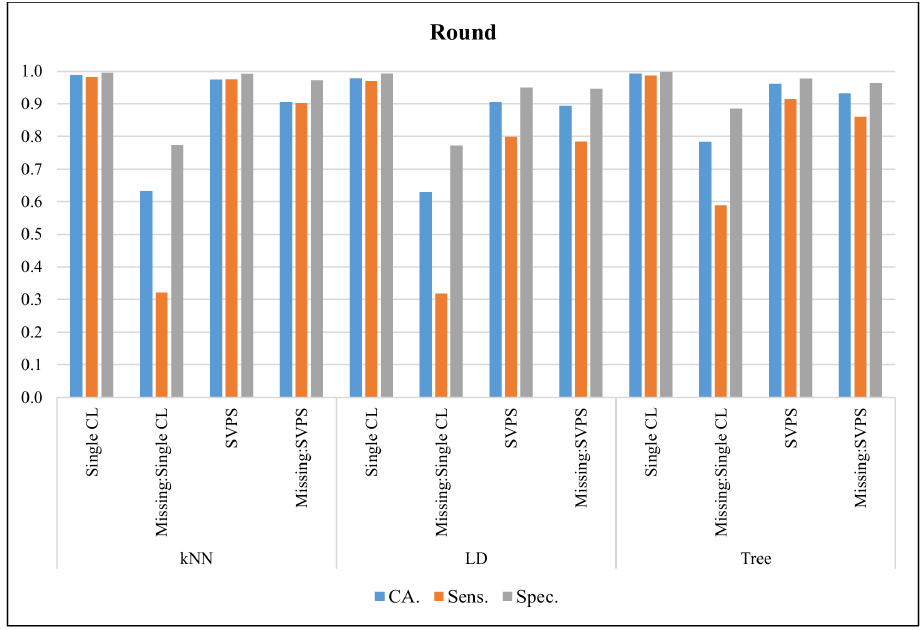
Figure 9. Classification results for Round